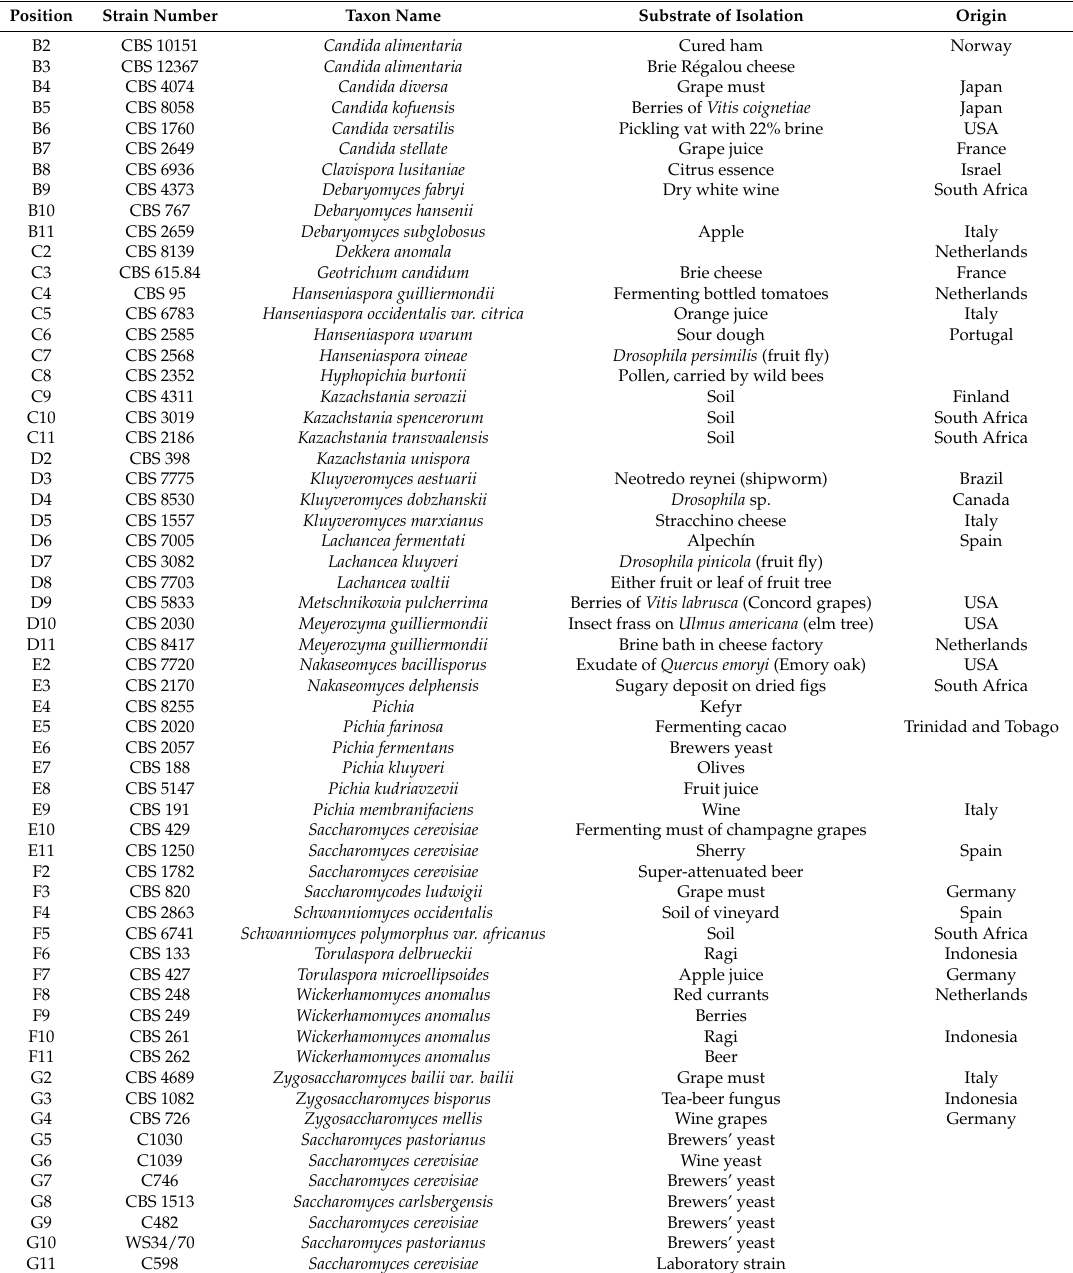
Table 1. Strains used in this study. Each selected strain was assigned to a code based on its coordinates on a 96-well